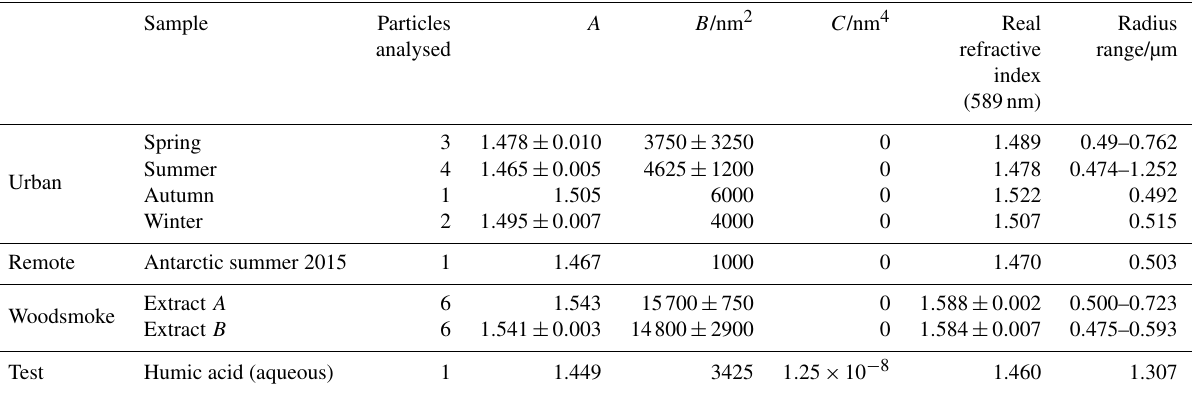
Table 1. The number of aerosols studied, their determined Cauchy coefficients, and the particle sizes. Many more particles were studied but were too small to produce Mie spectra that could be fitted with confidence (i.e. the Mie spectra lacked structure). A very limited amount of samples prevented a larger aerosol becoming optically trapped. Where more than one particle was analysed for a single type of sample, e.g. urban spring, the average and standard deviation of the Cauchy coefficients and real refractive index were reported for the particle studied. The standard deviation does not reflect the uncertainty estimated from the fitting process (which is ± 0.015 for the real refractive index) but a spread of values obtained for the few particles studied. The range in particle sizes studied is also reported. Note that the woodsmoke aerosol extract was plentiful and that repeated experiments could be